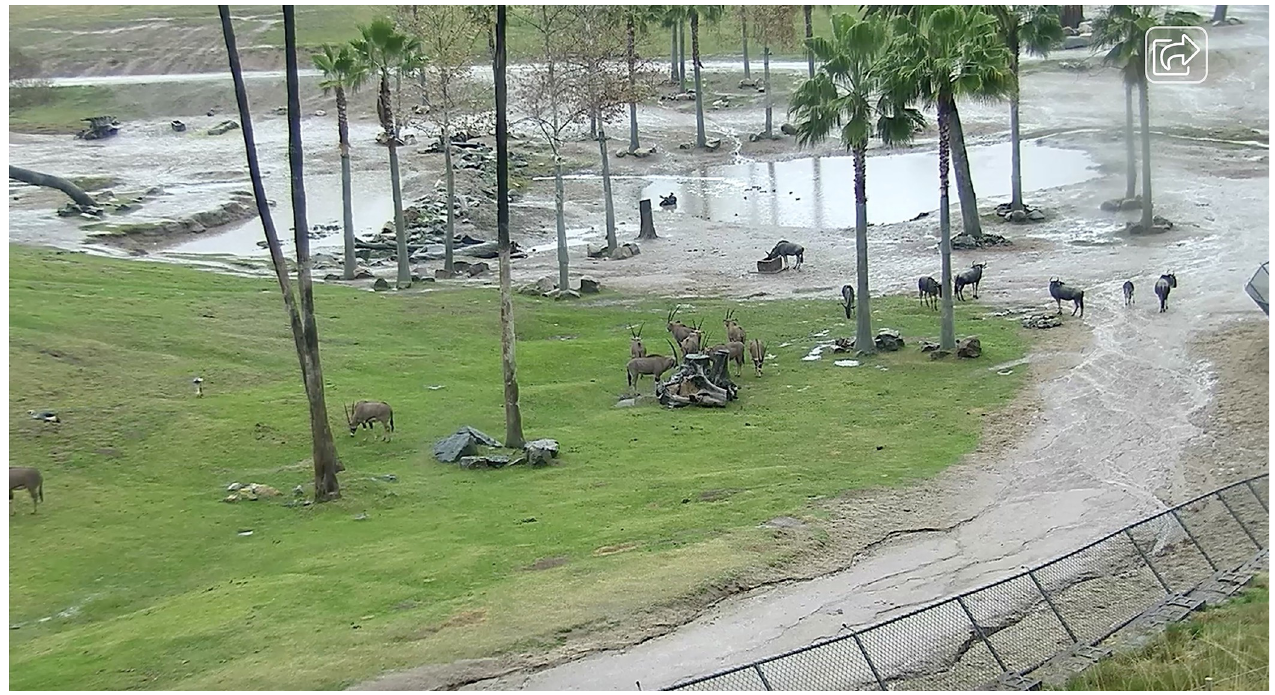
Fig 1. An example of associations between oryx and wildebeest from the San Diego Zoo Safari Park’s “African Plains” exhibit. Screenshot of webcam footage.